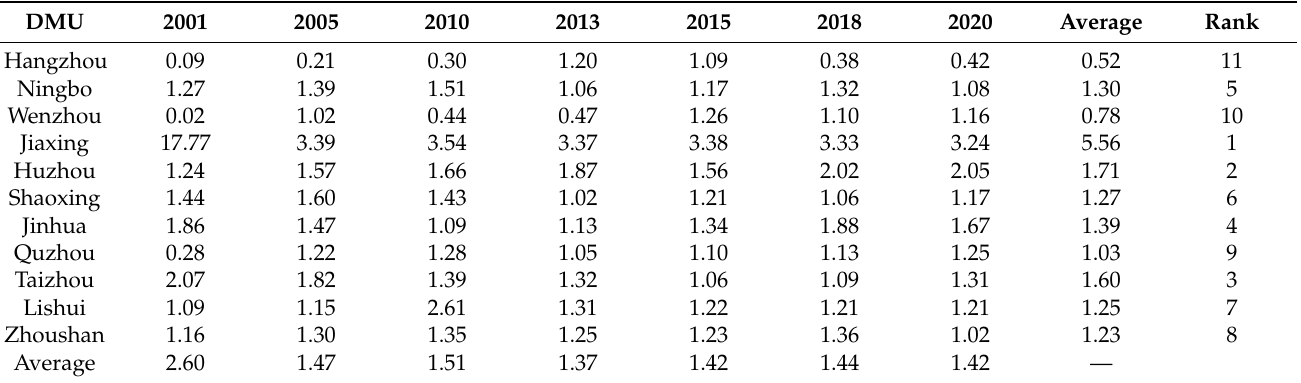
Table 4. Ranking of the mean value-conversion efficiency of forest ecological products in cities in Zhejiang Province from 2000 to 2020.